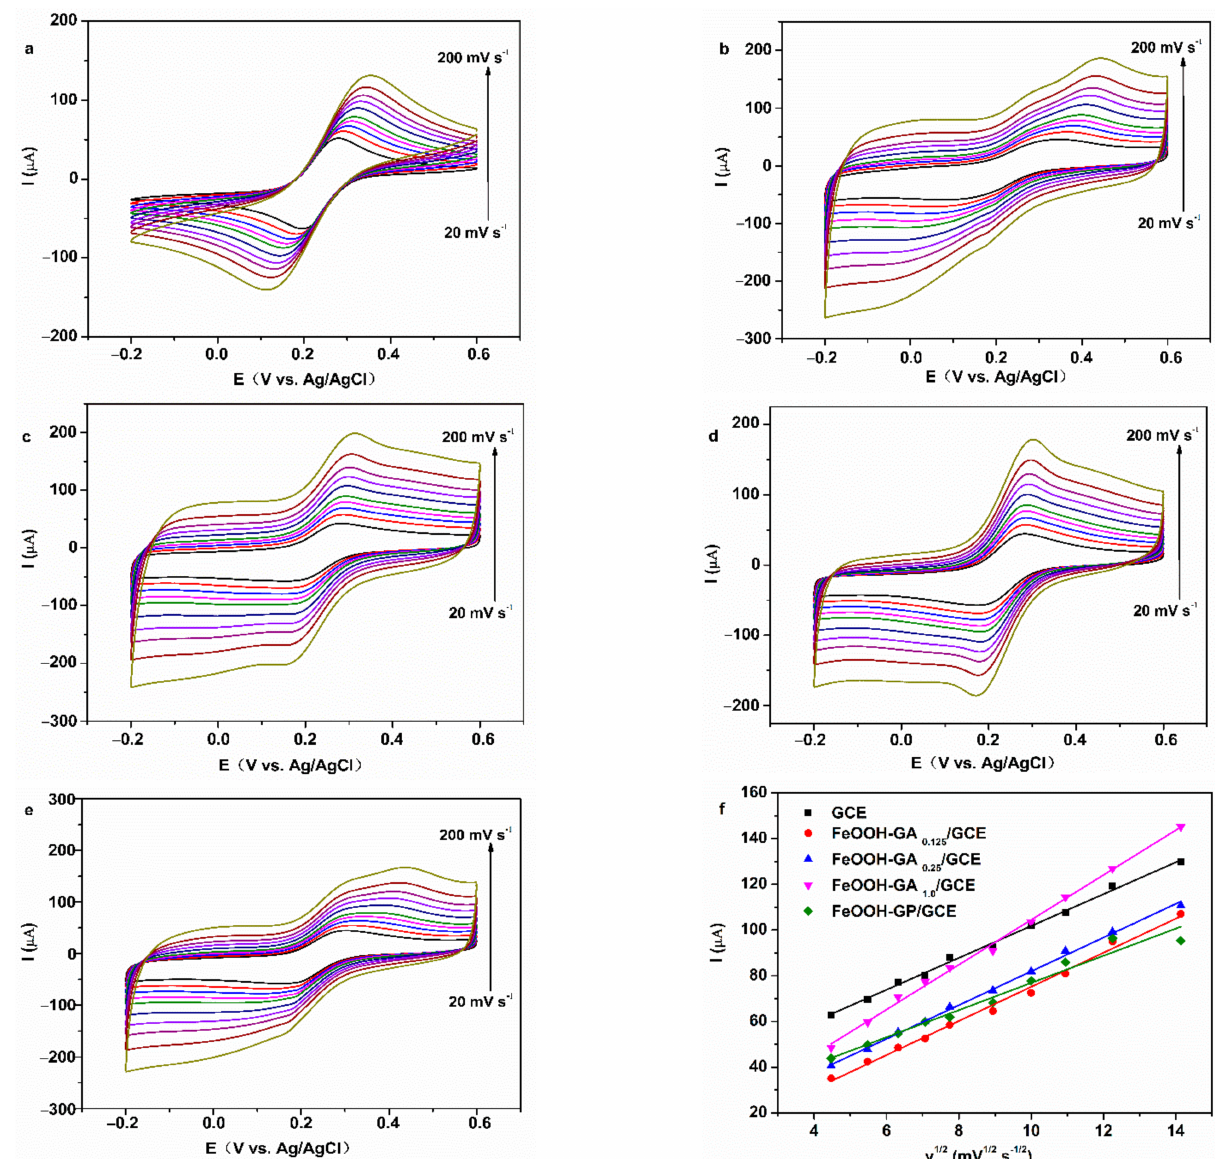
Figure 9. The CV curves of GCE ( a ), FeOOH-GA 0.125 /GCE ( b ), FeOOH-GA 0.25 /GCE ( c ), FeOOH-GA 1.0 /GCE ( d ) and FeOOH-GP/GCE ( e ) in 5 mM K 3 [Fe(CN) 6 ] + 0.1 M KCl solution at various scan speed, ( f ) plo of I pa vs. square root of scan rate from ( a – e